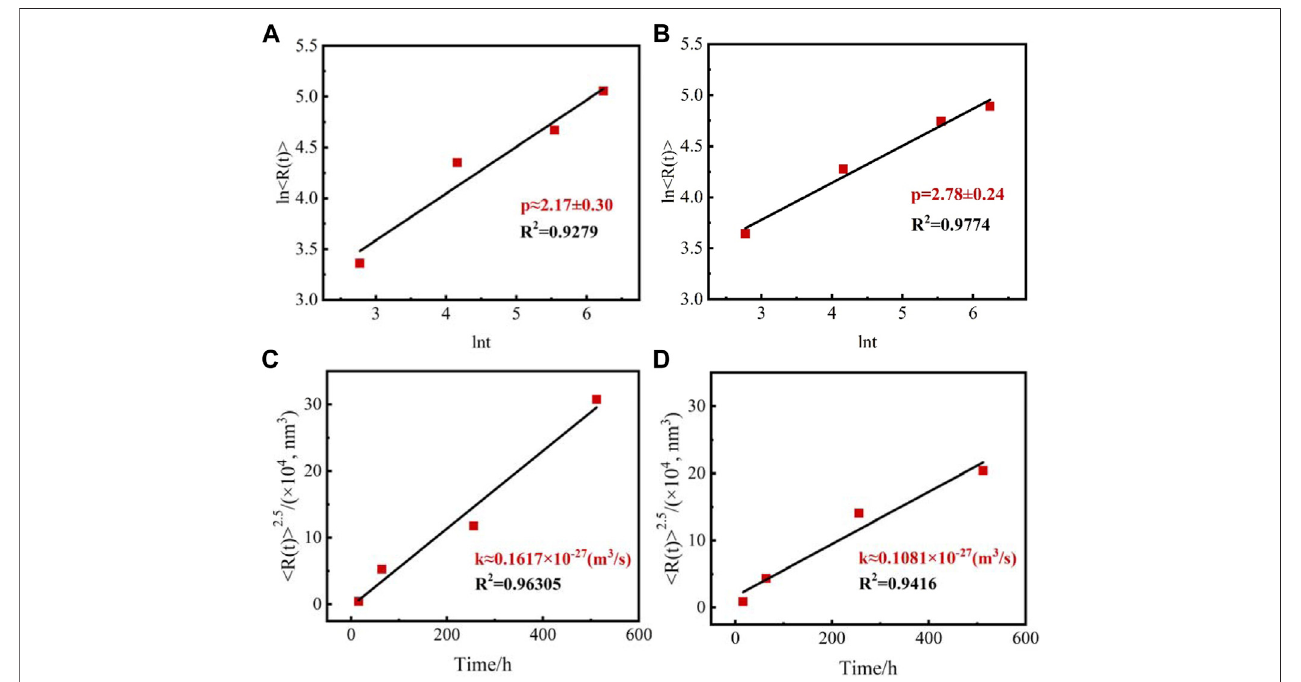
FIGURE 8 | The plot of ln R (t) as a function of ln t during aging at 1073 K, and the 2.5 power of the mean precipitate radius [ R 2.5 (t) ] vs. aging time ( t ) during aging at 1073 K: (A,C) 2Cr, (B,D) 2Mo.